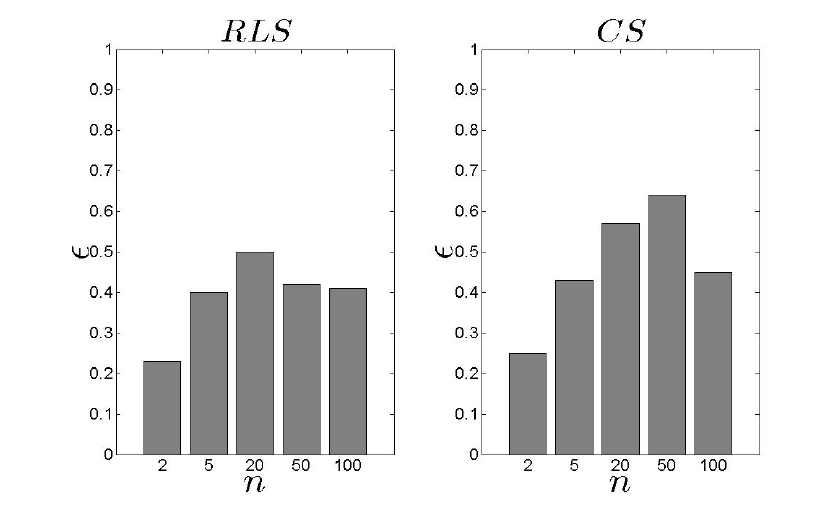
Figure 8. RLS and CS results for the (cid:101) metric ( |F| = 10).